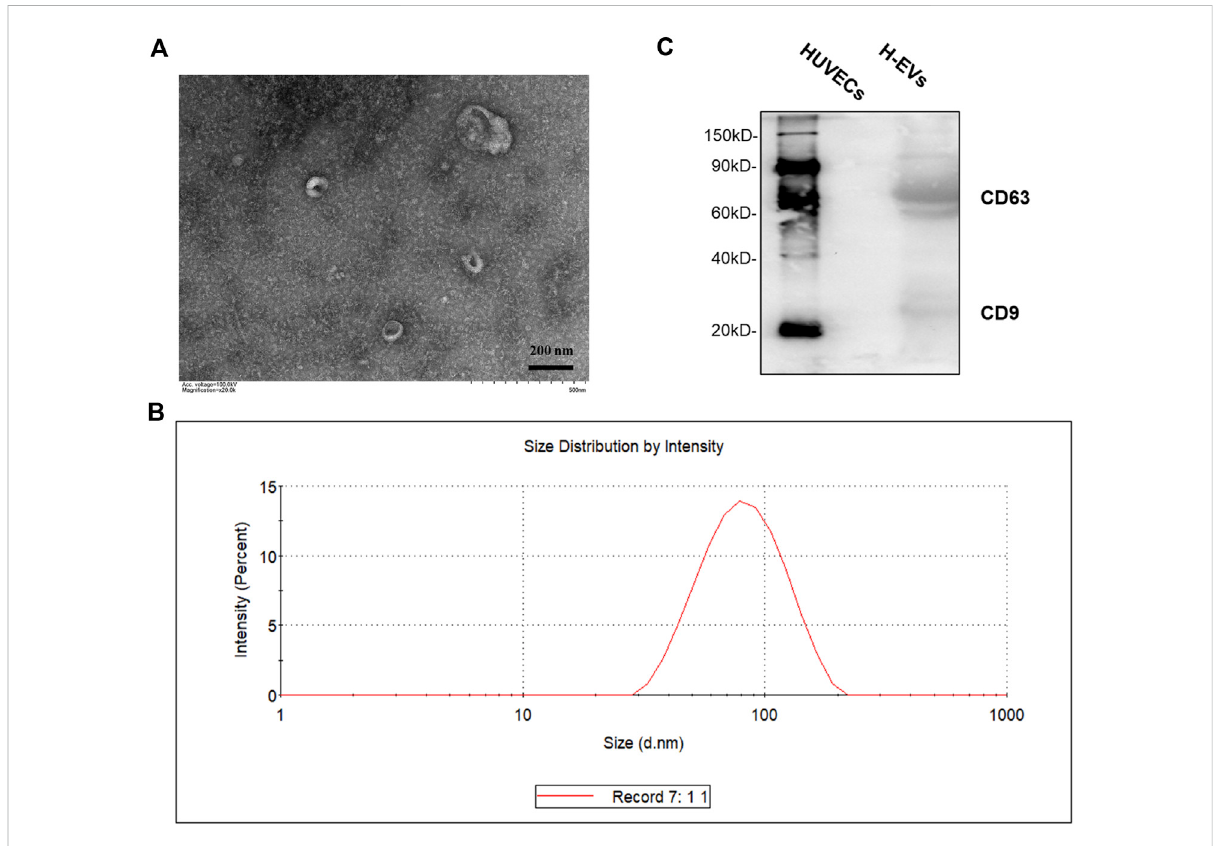
FIGURE 1 CharacterizationofHUVECsderivedEVs(H-EVs). (A) Examination ofisolated EVsbyTEM. (B) Thesizedistributionofexosomeswasdetermined by DLS. (C) The expressions of EVs biomarkers CD9, CD63 in EVs samples were detected by Western